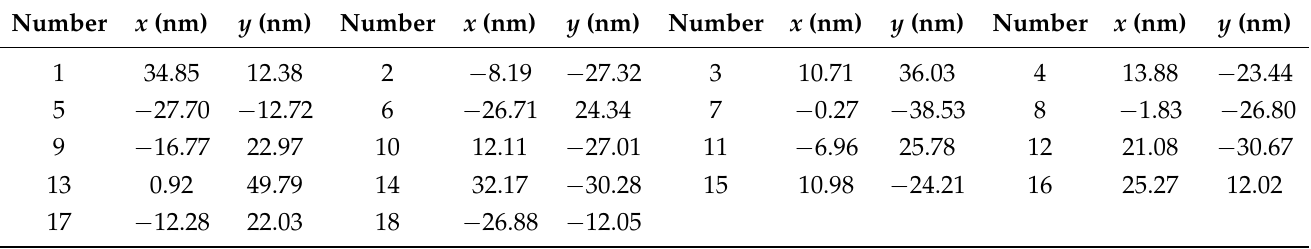
Table 2. The displacement coordinates of the air holes with the relative displacement of the curved Z waveguide greater than 25 nm. Number is the number of the selected air holes. x and y represent the relative displacement of the selected air holes in different directions.